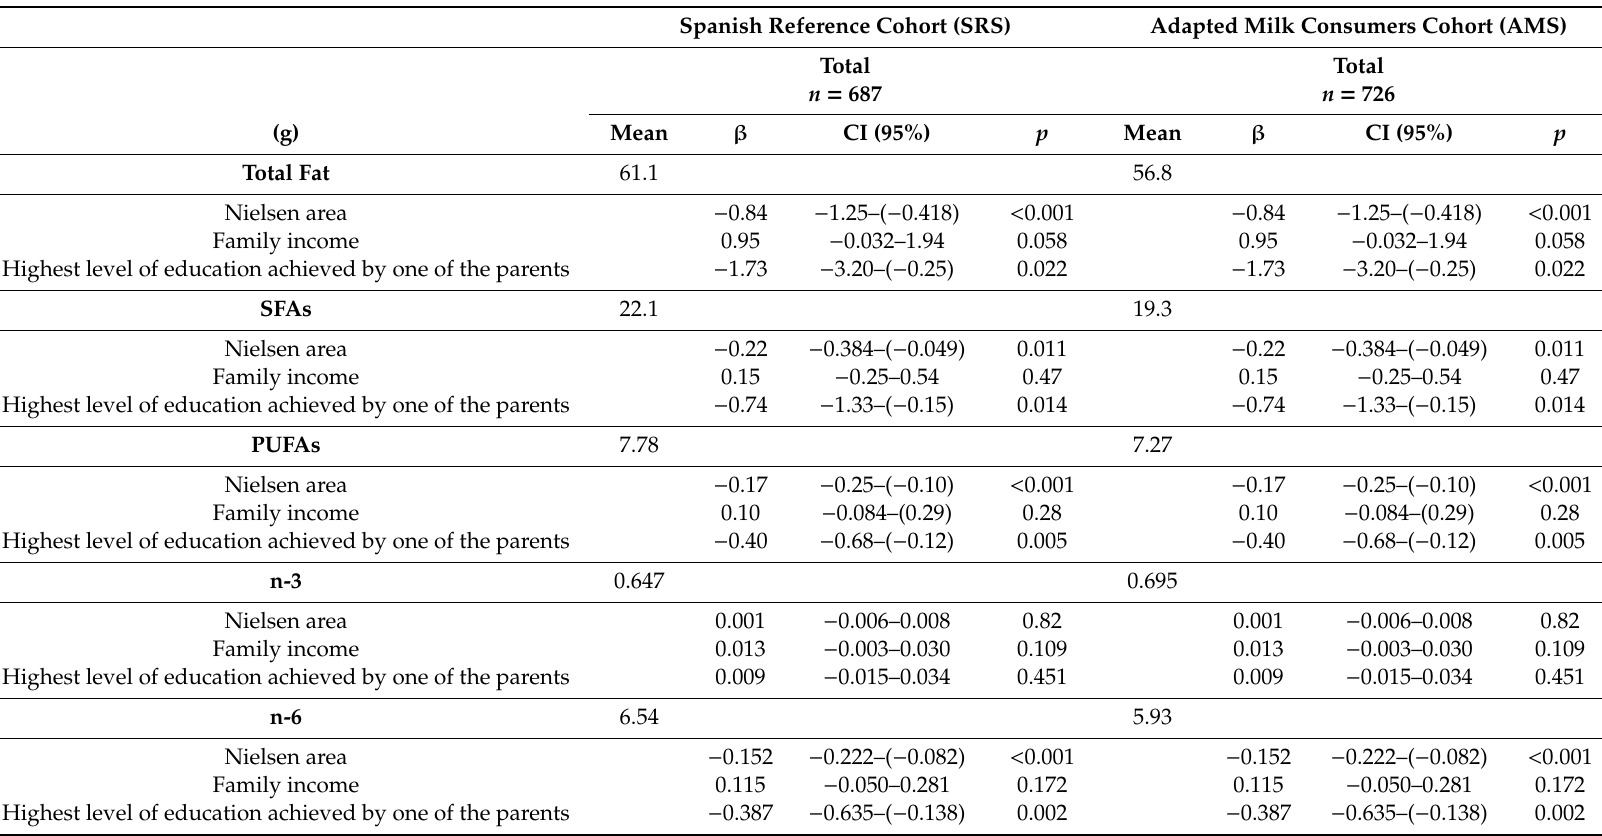
Table 5. Covariance analysis (ANCOVA) of variables associated with main fatty acid intakes from two 24 h dietary recalls of the two cohorts of the Nutritional Study in the Spanish Pediatric Population (EsNuPI) ( n =